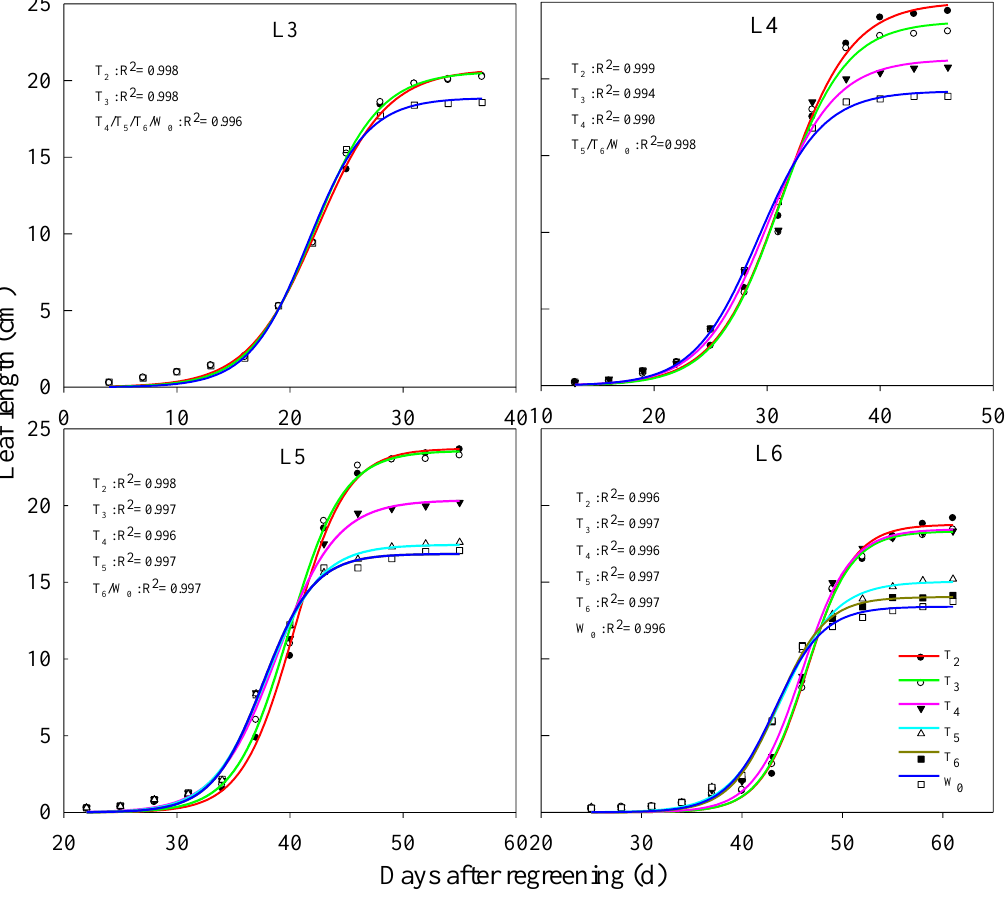
Figure 3. Growth process of each leaf in the growing season from 2020 to 2021. L3–L6 represent the third leaf to the sixth leaf in springtime.